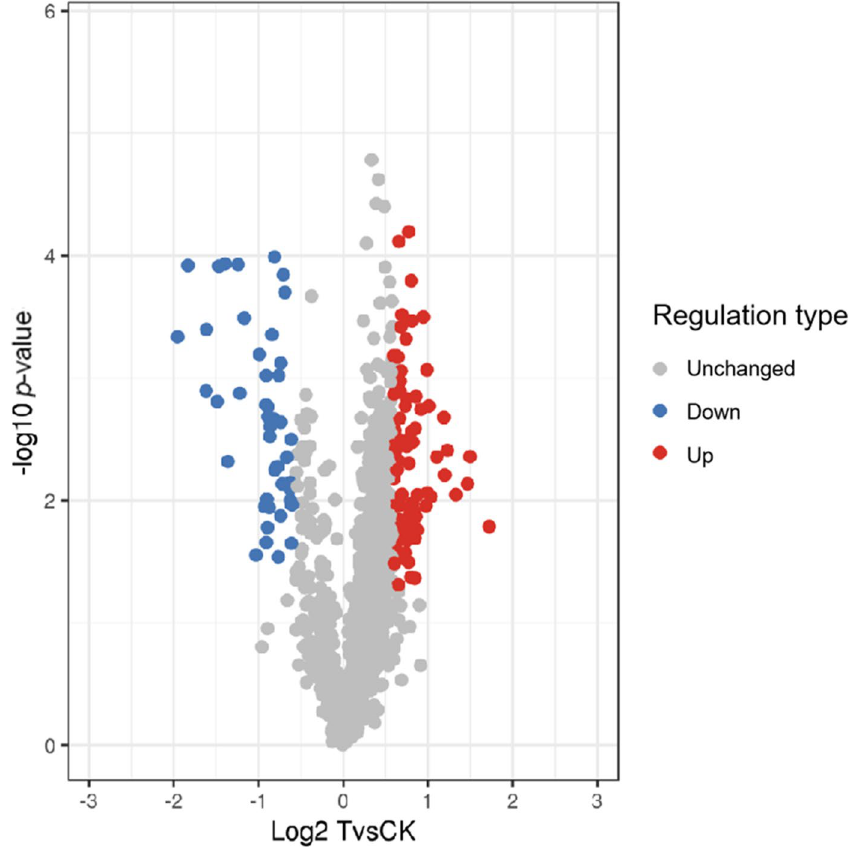
Figure 3. Volcano plot of differentially modified Kac sites in C. chloroleuca